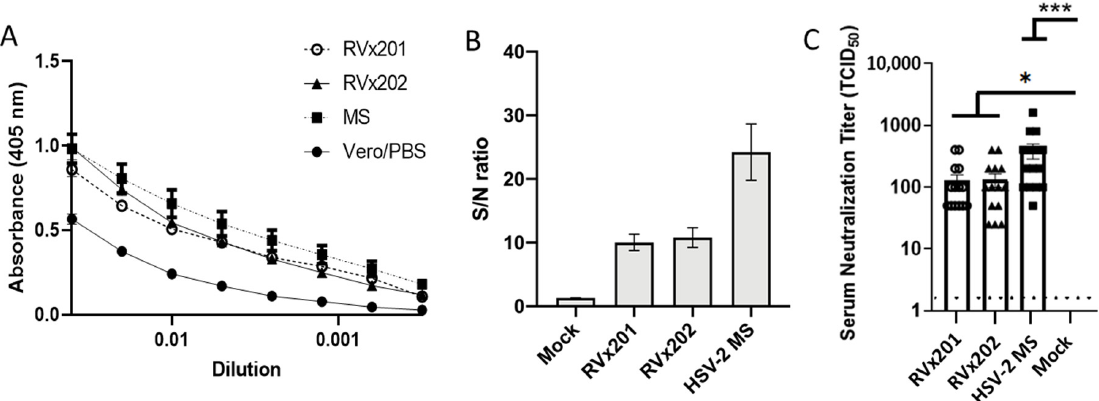
Figure 5. Serum antibody response. Guinea pigs ( n = 3–15/group) were inoculated ID with RVx201, RVx202, MS, or control (Vero cell lysates or PBS) intradermally. Twenty-eight days post infection serum was collected and assayed for reactivity to HSV-2 antigen by ( A ) ELISA or ( B ) ADVIC test. Average sample-to-noise (S/N) ratios represent pan-HSV2 immune response. ( C ) Serum neutralization titers against HSV-2. Data are presented as mean ± SEM. *** p < 0.001, * p < 0.05 comparing the indicated groups by Kruskal–Wallis non-parametric ANOVA and Dunn’s multiple comparison test.